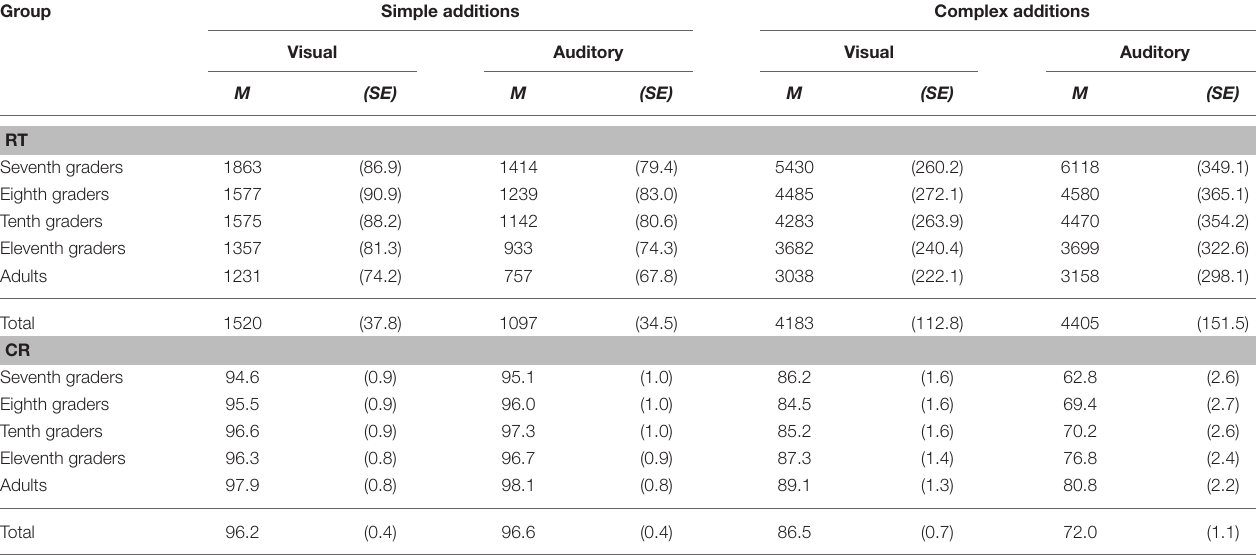
TABLE 3 | Means of reaction times (RT) in ms and correct response rates (CR) in % with standard errors for each presentation format of the simple and complex additions as a function of age-group. Group Simple additions Complex additions Visual Auditory Visual